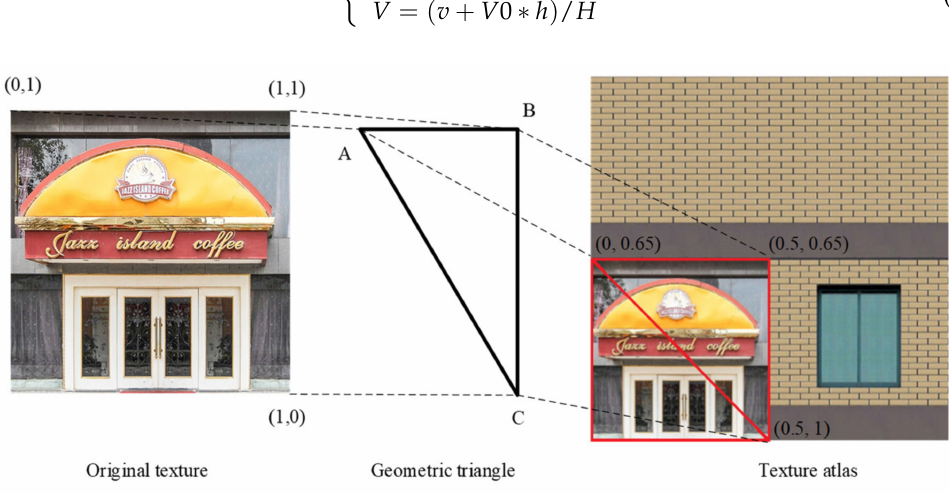
Figure 5. Non-tiled texture